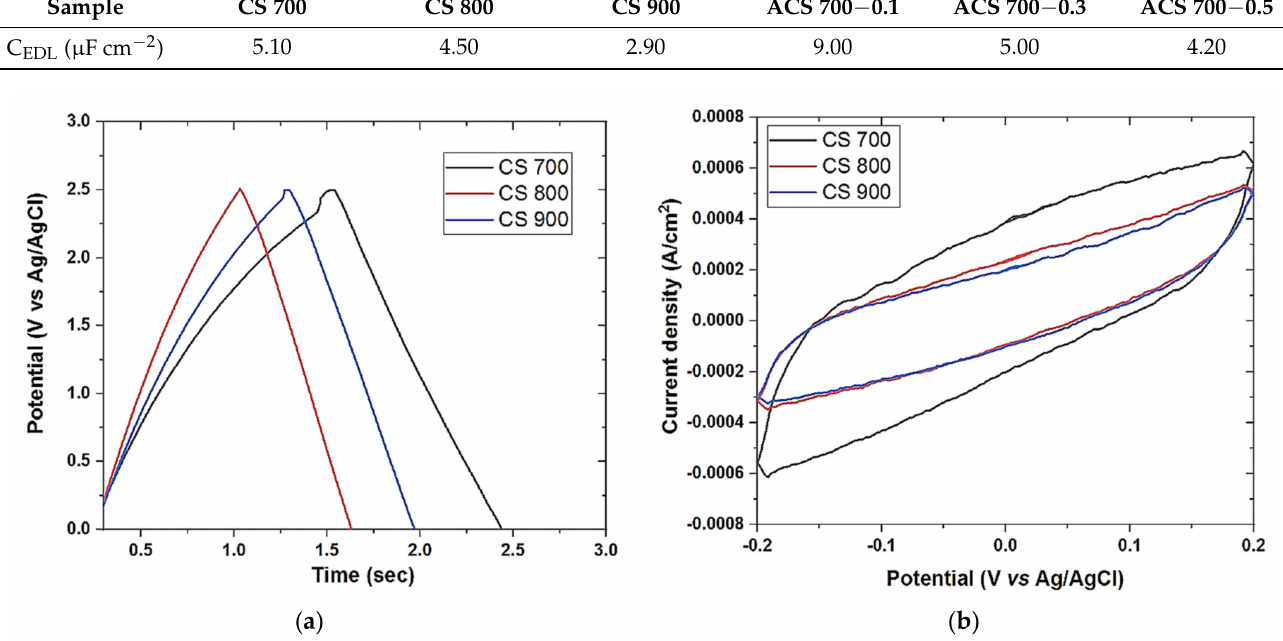
Table 5. Electrical double layer capacitance (C EDL ) calculated from the charge and discharge currents of the CV curves of the synthesized carbons in aqueous solution. Sample